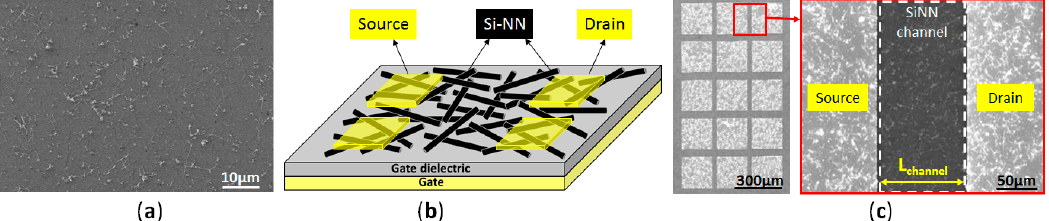
Figure 1. ( a ) SEM image of silicon nanonets elaborated from 28 mL of NW suspension; ( b ) Bottom configuration of SiNN FET; ( c ) SEM image of as-fabricated SiNN